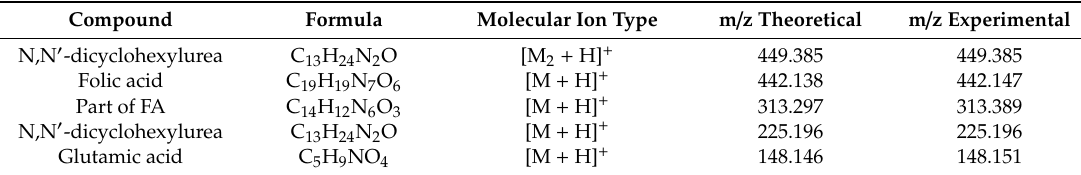
Figure 6. Fourier-transform ion cyclotron resonance mass spectrometry (FT ICR MS) spectrum of formic acid treated FA / EDA-BNNPs PT sample. Table 3. Main ions detected by FT ICR